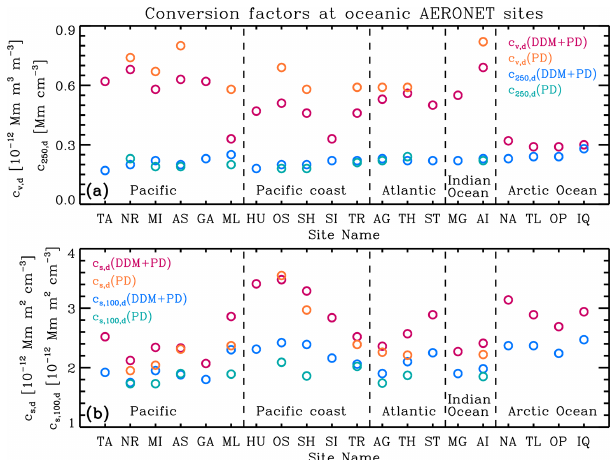
Figure 6. Dust-related conversion factors at 20 oceanic and coastal sites. (a) c v , d and c 250 , d , as well as (b) c s , d and c s , 100 , d , calculated by considering PD and DDM+PD datasets,